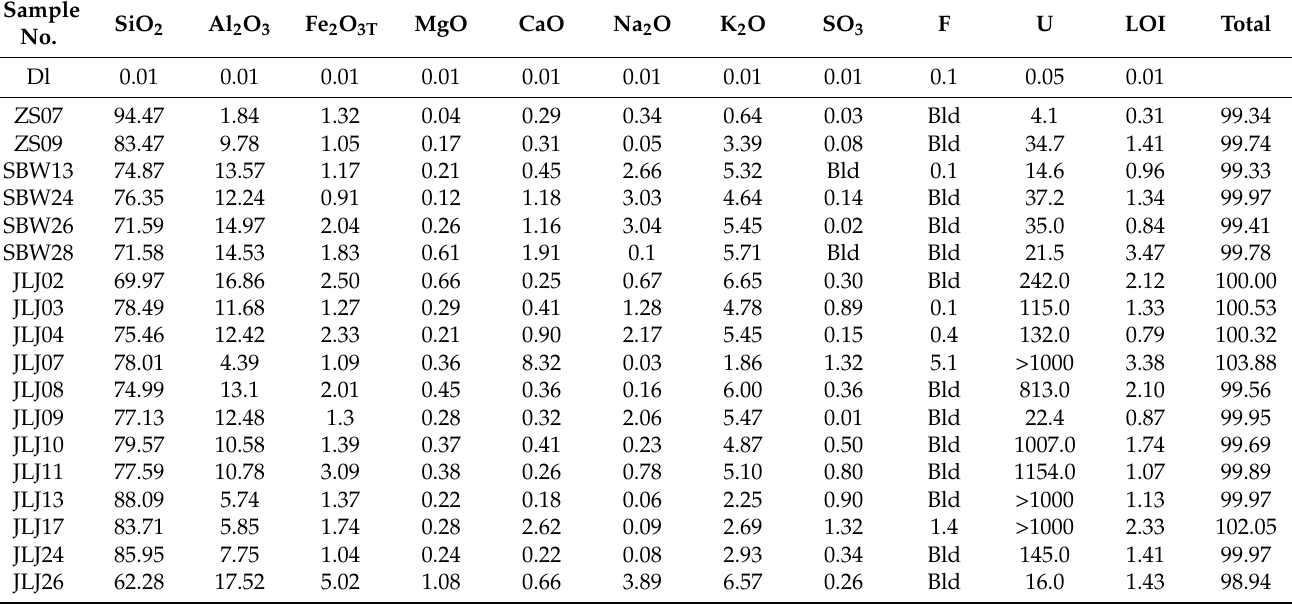
Table A1. Major element oxide (wt%) and U (ppm) analyses of SJOF granite